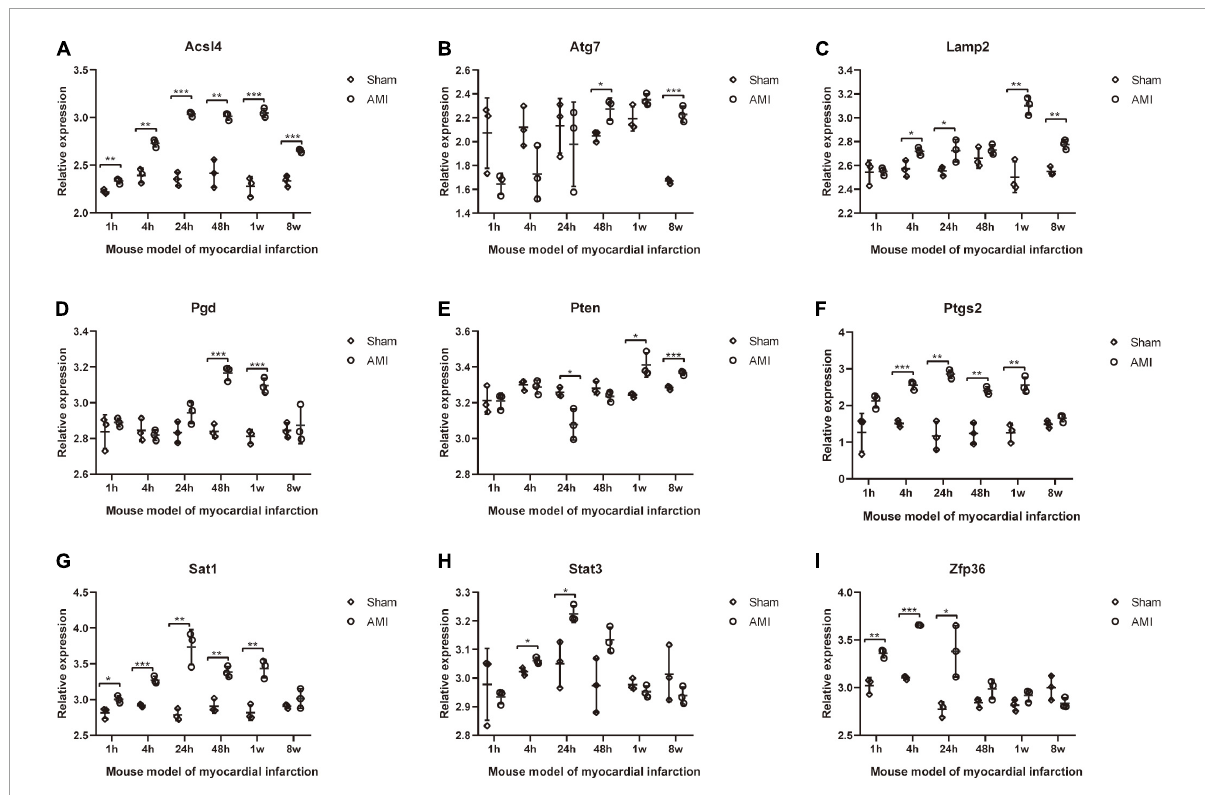
FIGURE8 Further validation of differentially expressed FRGs in Mouse model of myocardial infarction dataset GSE775. (A–I) * P < 0.05; ** P < 0.01; *** P <